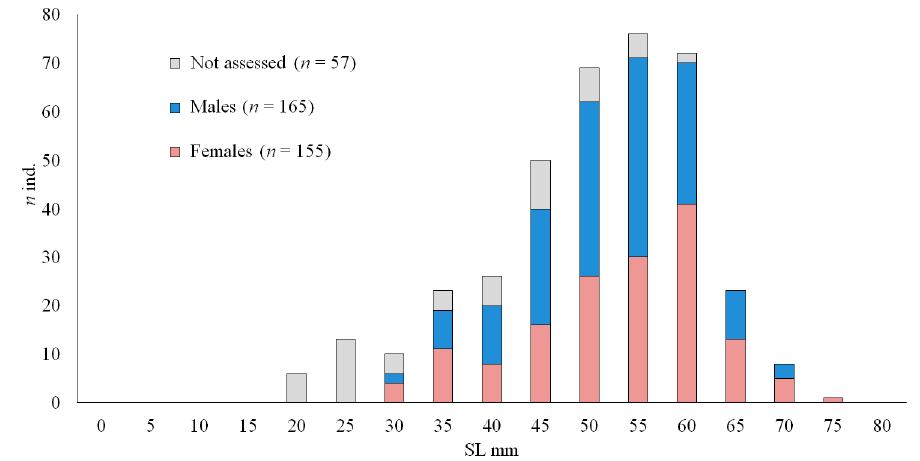
Figure 2. Length frequency distribution by sex of the studied sample of Myctophum punctatum .